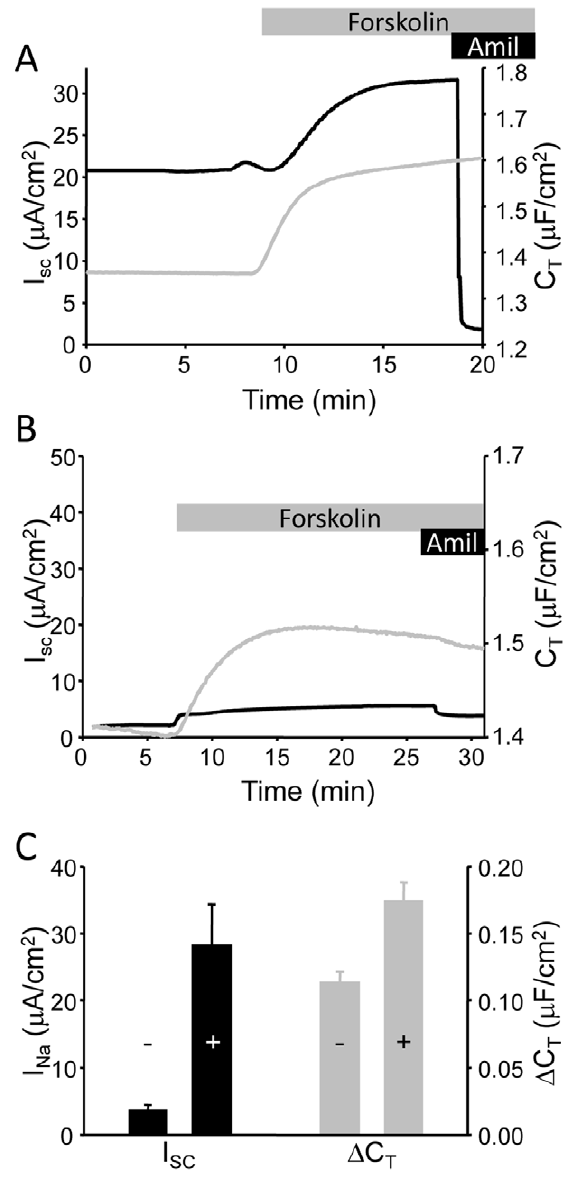
Figure 1. I SC and C T recordings with and without hormonal supplementation. (A) Representative I SC (black trace) and C T (grey trace) recording from mpkCCD cells mounted in modified Ussing chambers and stimulated with (10 m M) forskolin. Addition of 10 m M amiloride at the end of the trace demonstrated the majority of the recorded I SC was Na + transport via ENaC. (B) A similar trace from mpkCCD cells cultured in the absence of dexamethasone supplemen- tation. (C) Summarized data for stimulated amiloride-sensitive current (I Na ) and C T response to forskolin stimulation (n=14) in cells with ( + ) and without (-) full